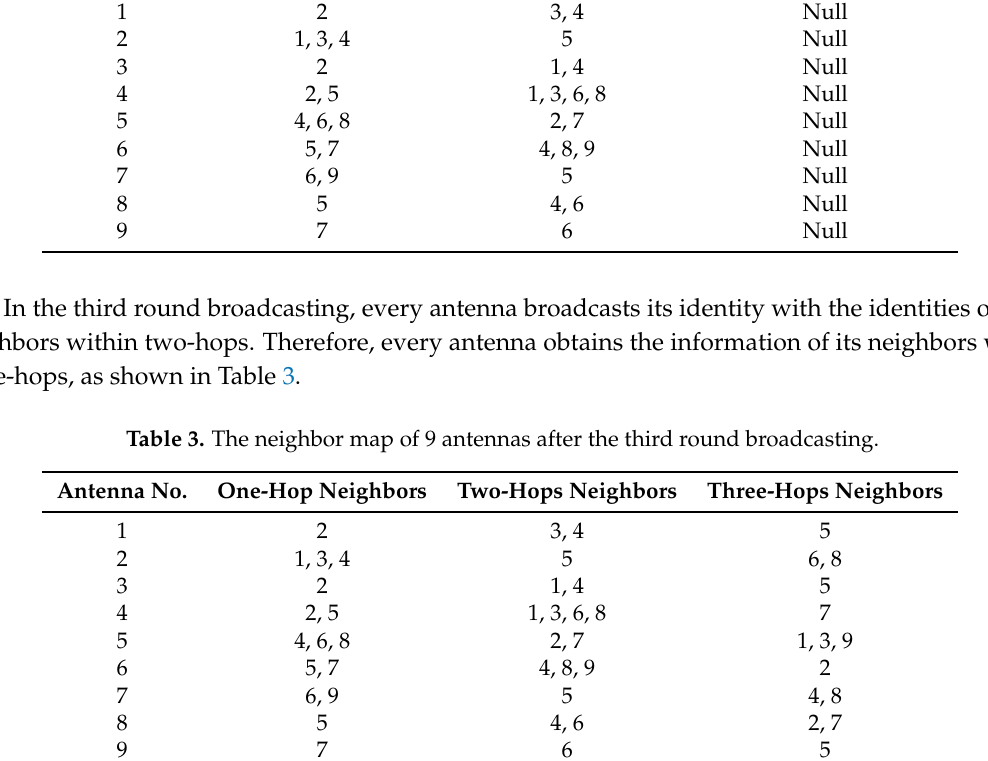
Table 2. The neighbor map of 9 antennas after the second round broadcasting. Antenna No.